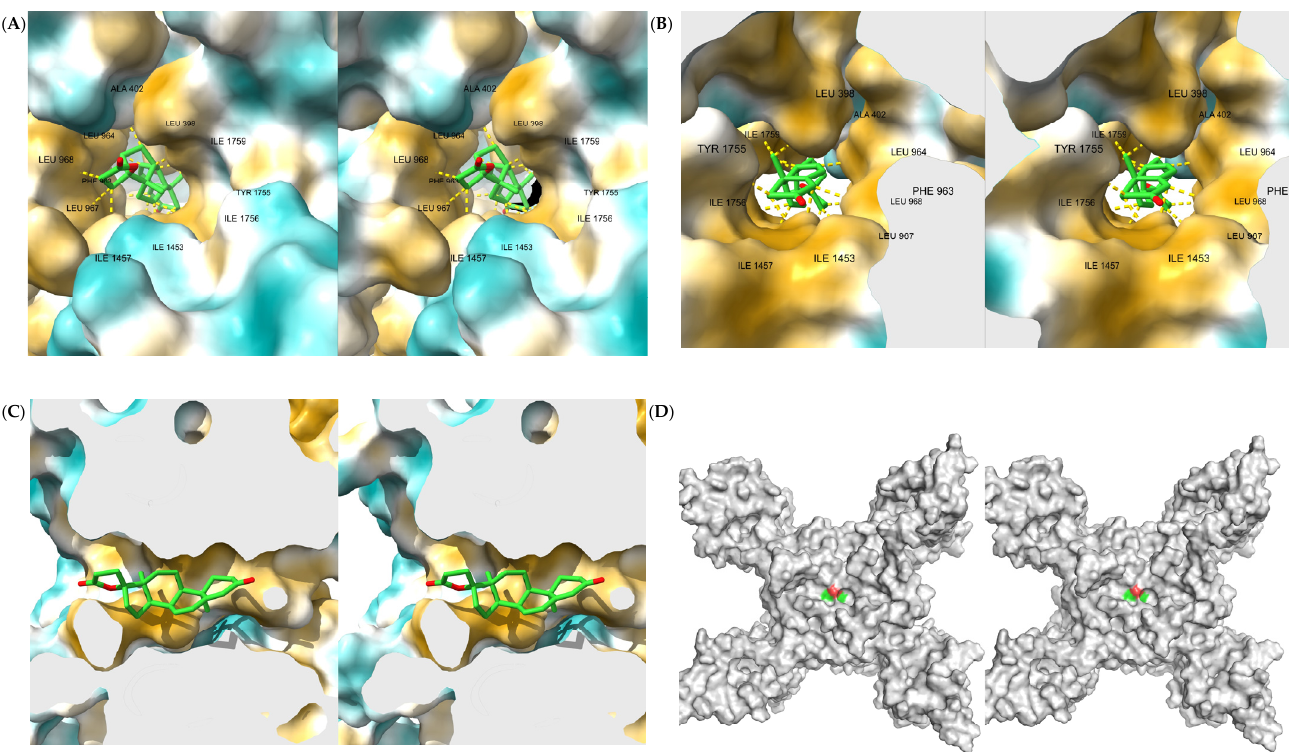
Figure 5. First-ranked ligand in its binding site as seen from outside the pore ( A ), from inside the pore using a section plane in light gray color ( B ), laterally by sectioning the pore using a section plane in light gray color ( C ), and as surface representation to confirm complete blocking of the pore ( D ) (cross-eye stereoimages).